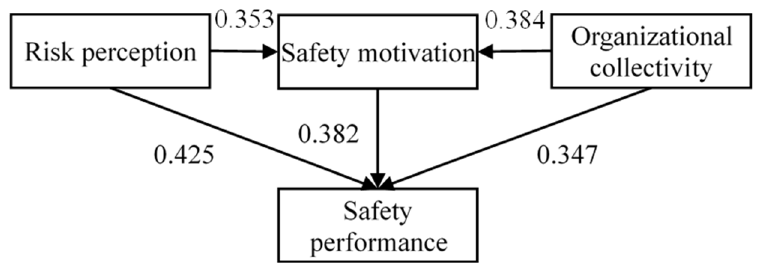
Figure 5. Structural equation modeling of SP in Mainland China.